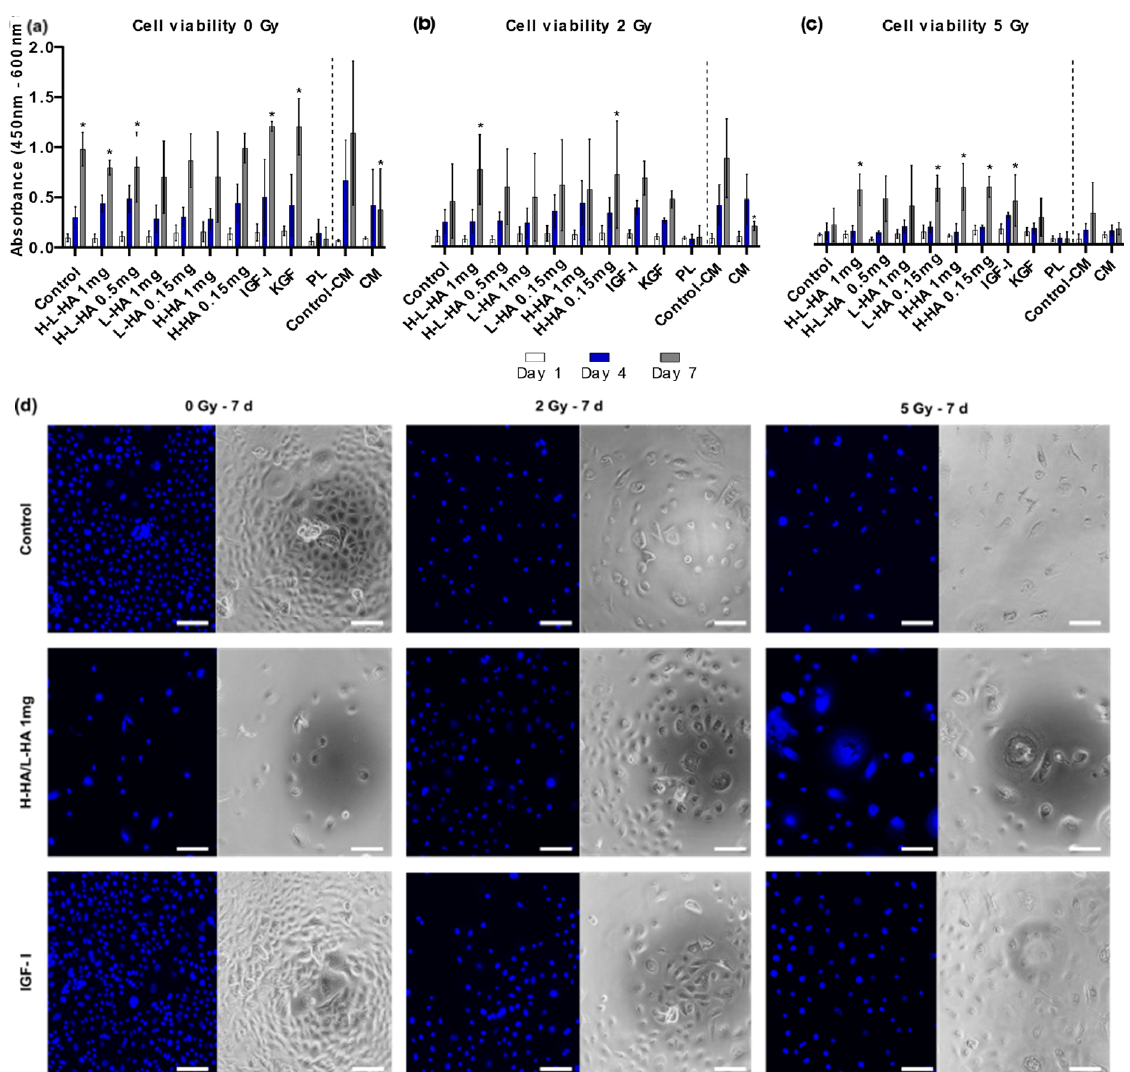
Figure 2. Keratinocyte viability of the irradiation groups, 0, 2, and 5 Gy with growth factor treatment, on 1 d, 4 d, and 7 d: ( a ) cell viability without irradiation ; ( b ) cell viability after irradiation with 5 Gy; ( c ) cell viability after irradiation with 2 Gy ; ( d ) representative images of irradiated keratinocytes at time point 7 d stained with DAPI (blue = living cells) and PH. Scale bar 200 µm. * p ≤ 0.05, significances were correlated to the respective control. Scale bar = 200 µm.